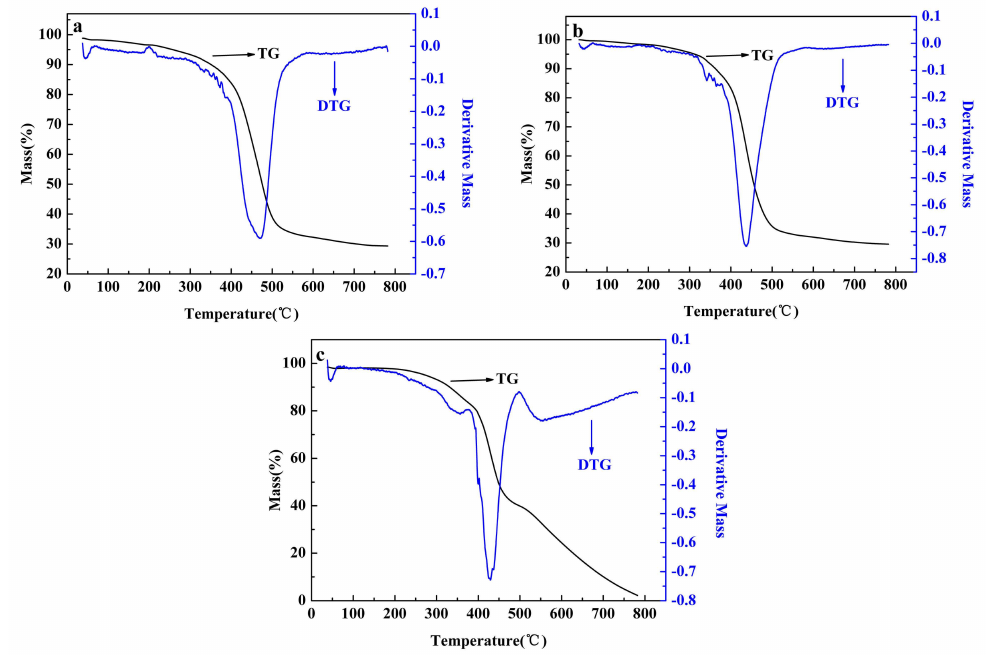
Figure 9. Thermogravimetric analysis of P1 ( a ); P2 ( b ); and P3 ( c